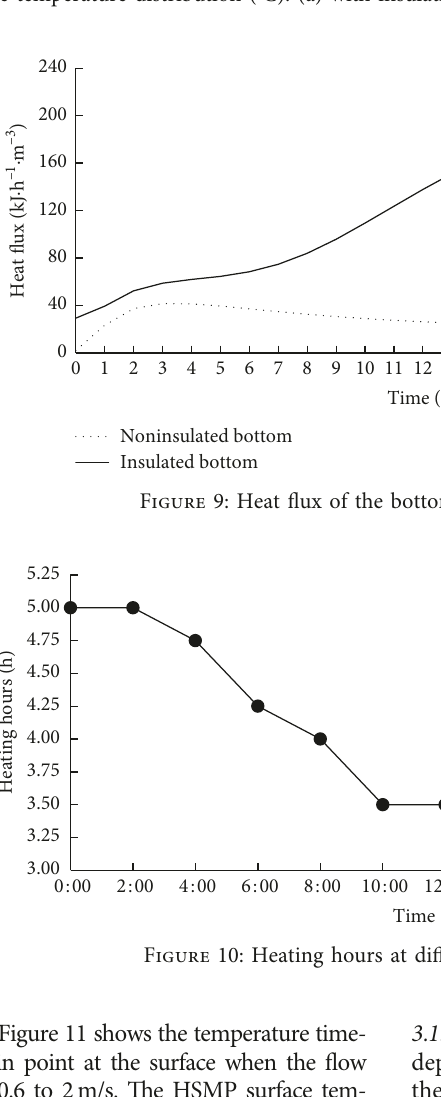
Figure 8: Pipe temperature distribution ( ° C): (a) with insulating the bottom; (b) without insulating the bottom.